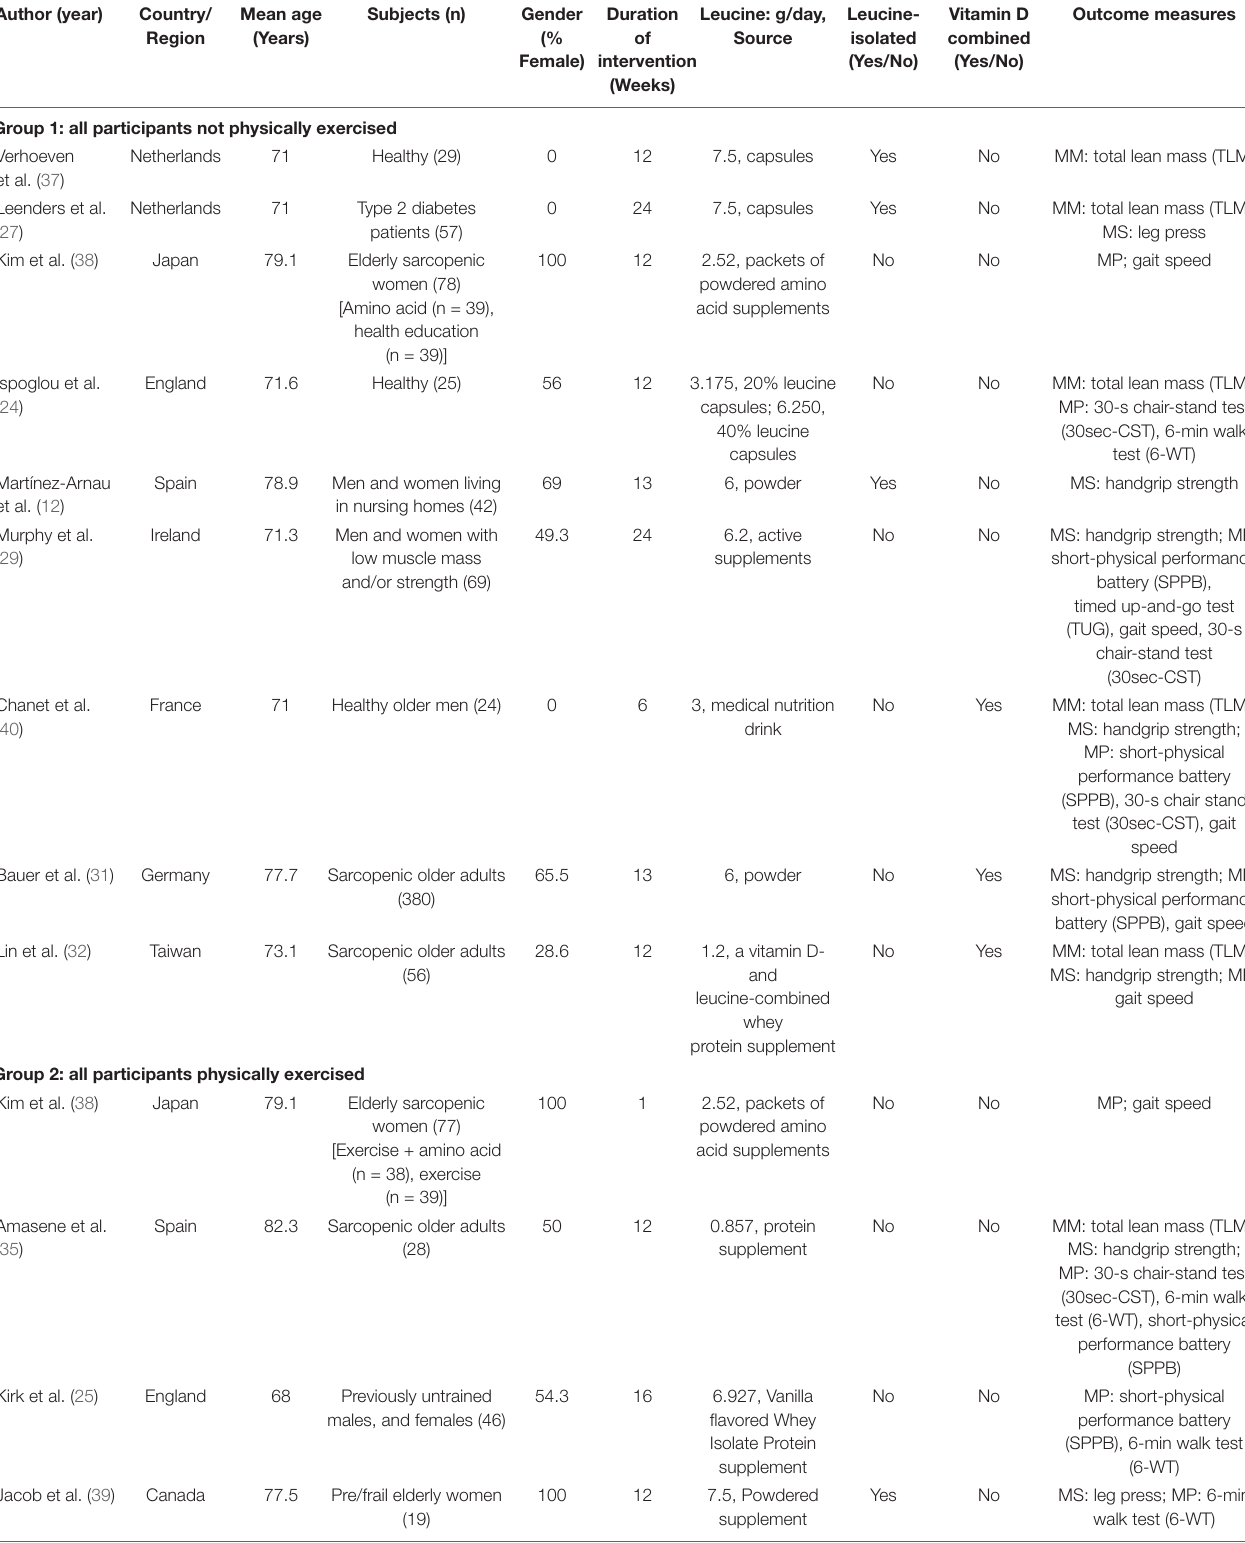
TABLE 1 | Study characteristics of the 17 included